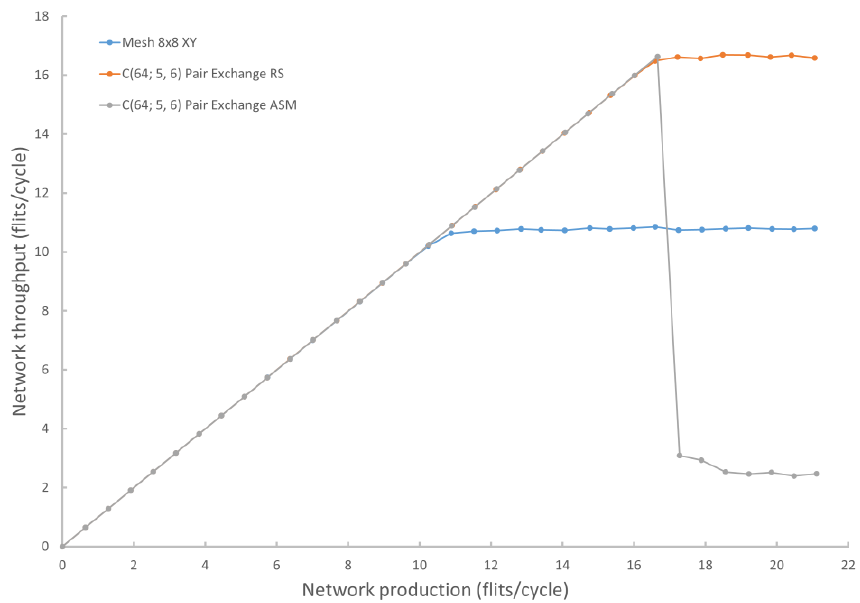
Figure 6. Diagram of throughput for various implementations of a network of 64 nodes using RS, ASM, XY.